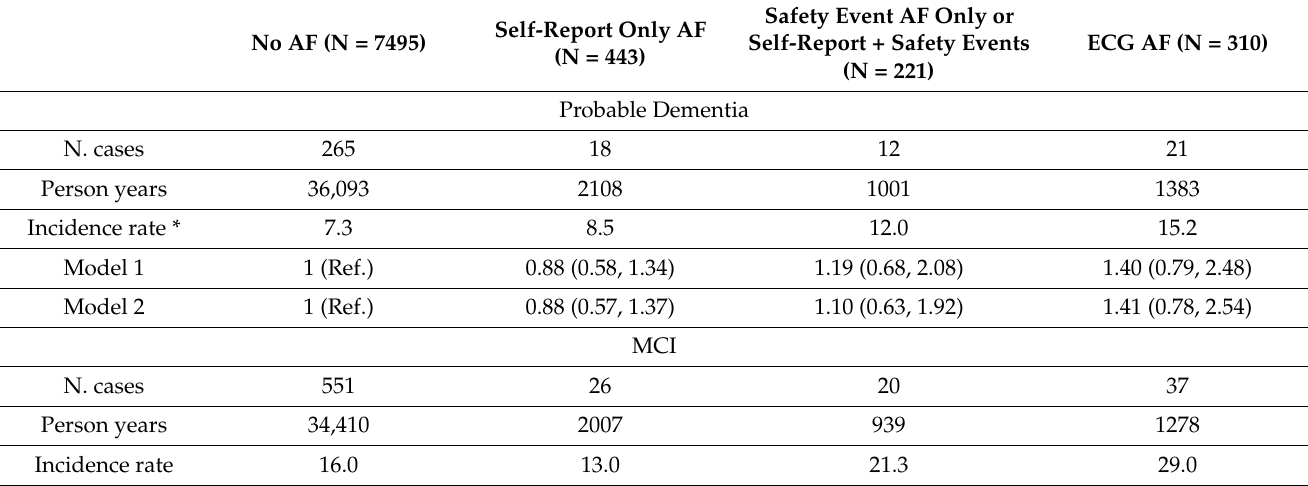
Table 4. Hazard ratios and 95% confidence intervals for association of 4 levels of time-dependent AF status with probable dementia and MCI,